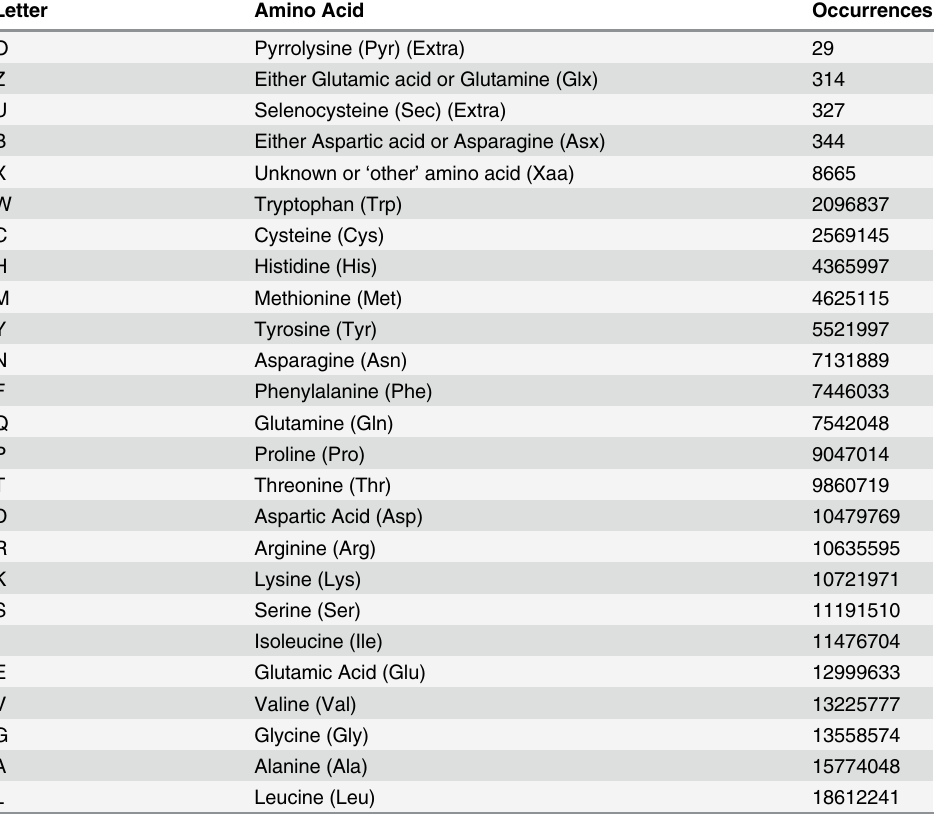
Table 3. The amino acids (ignoring any post-translational modification) found in the protein se- quences of SwissProt version 13-11, in increasing order of frequency. The total number of amino acids here is